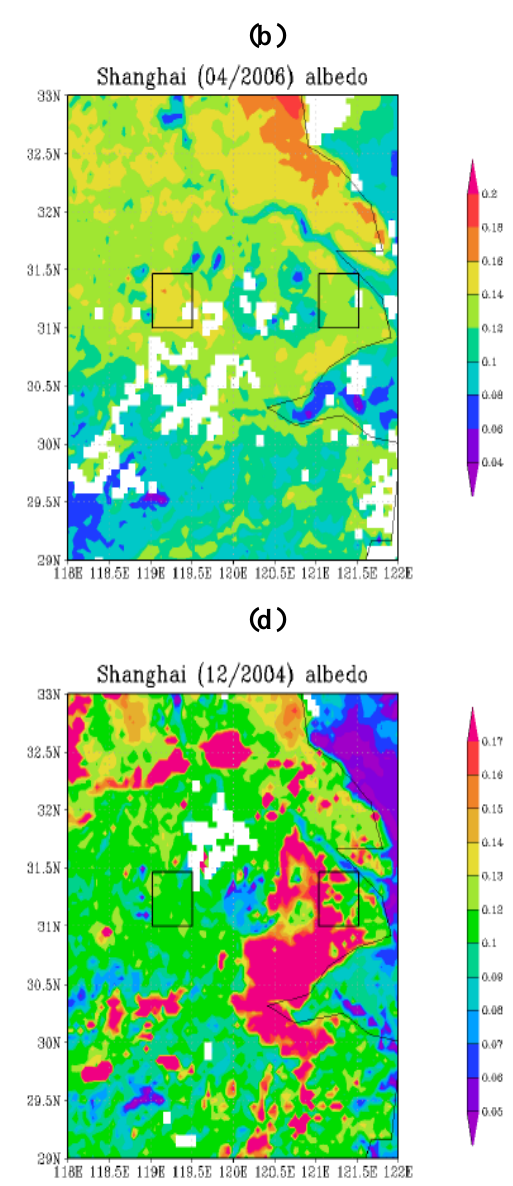
Figure 6. Albedo in 2004 for (a) January, (b) April, (c) July, and (d) December with Shanghai (right box) and rural (left